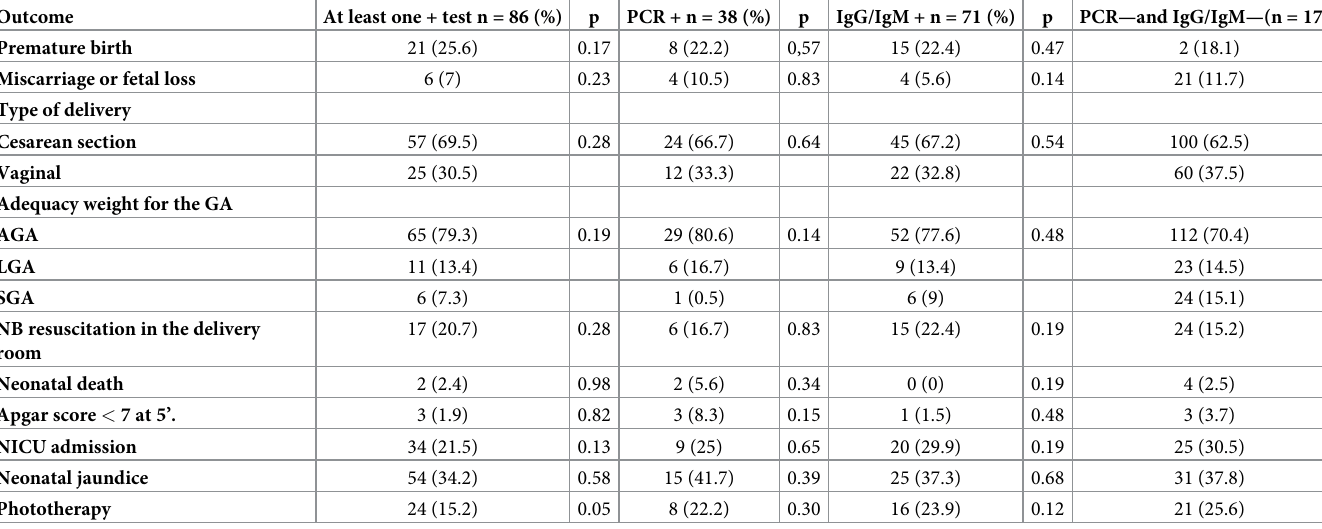
Table 5. Obstetric outcomes 19 by test type and result (N = 265).